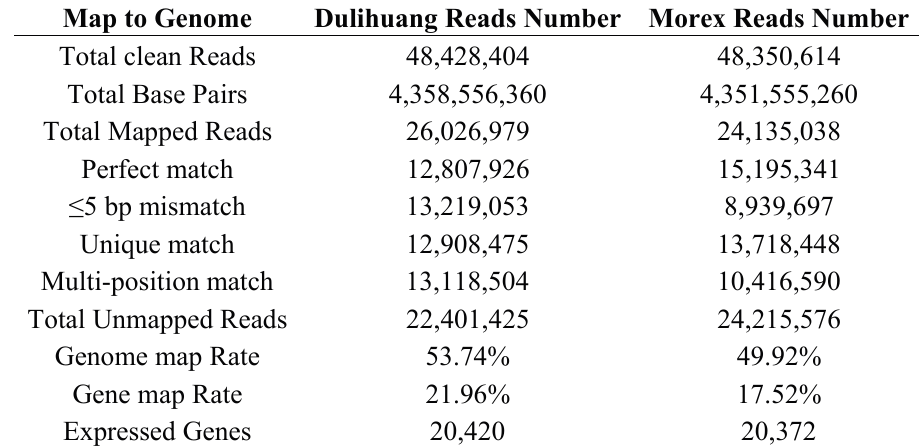
Table 1. Read number and statistics based on the RNA-Seq data in the two libraries of barley